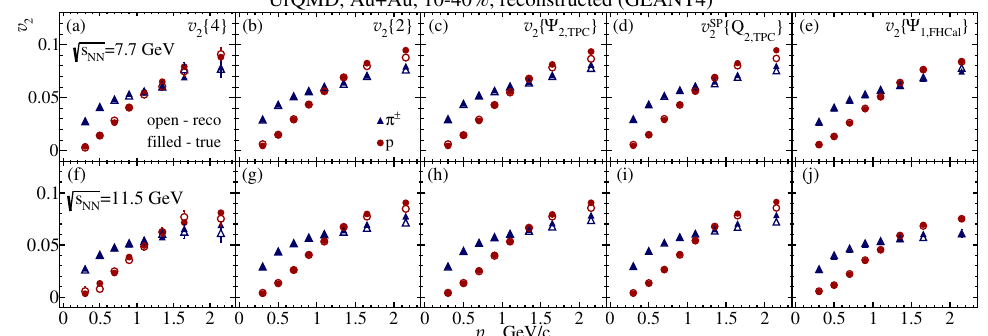
Figure 8. Comparison of v 2 ( p T ) for pions and protons in 10–40% mid-central Au+Au collisions √ √ s NN = 7.7 GeV and s NN = 11.5 GeV obtained by four-particle cumulants ( a , f ), two-particle at cumulants ( b , g ), TPC event plane ( c , h ), TPC scalar product ( d , i ), FHCal event plane ( e , j ) methods of fully reconstructed (“reco”) and generated UrQMD events